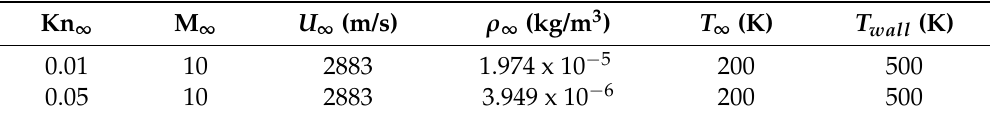
Figure 13. Normalized surface quantities across the compression corner. Comparison with experimental [53] and numerical [54] results. Table 7. Cylinder with slip flow conditions.